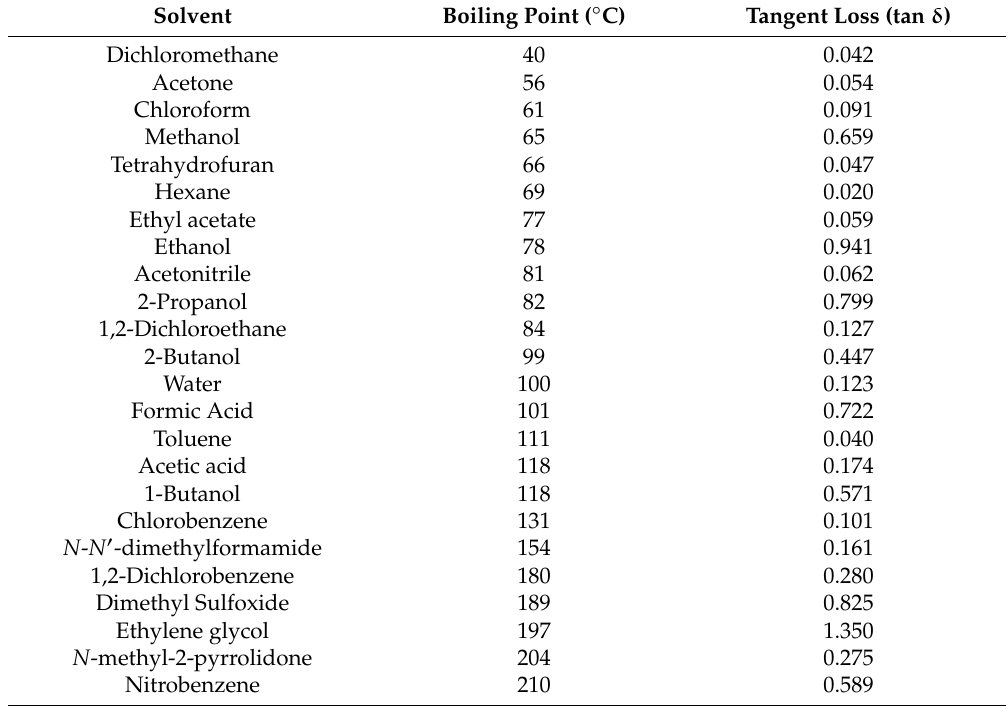
Table 1. Loss tangent values in the order of increasing boiling points for di ff erent solvents and commonly used acronyms (parentheses) under µ